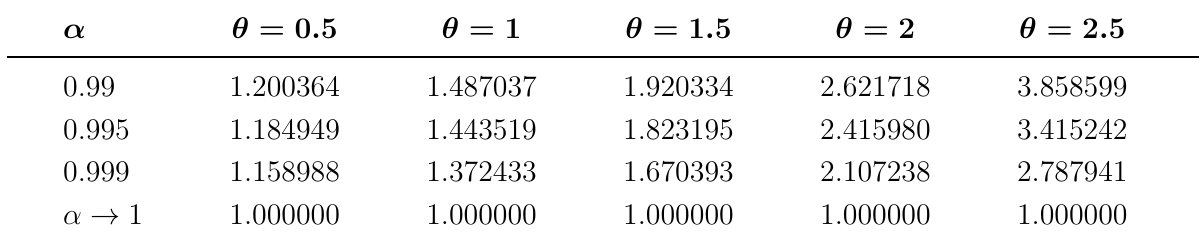
Table 2. Values for the ES/VaR ratio for LogN (0 , θ )